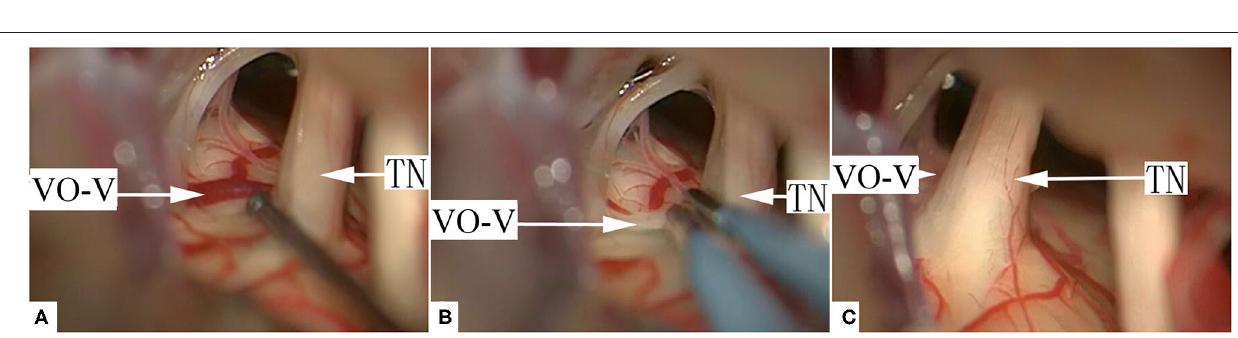
FIGURE 2 | A representative case of typical group I, type A VO-VREZ. (A) The full route of the vein was covered by the nerve root entrance/exit zone. (B) The VO-VREZ was electrocoagulated. (C) The trace of VO-VREZ after electrocoagulation and division. TN, trigeminal nerve; VO-V, venous offending on the ventral side of root entrance/exit